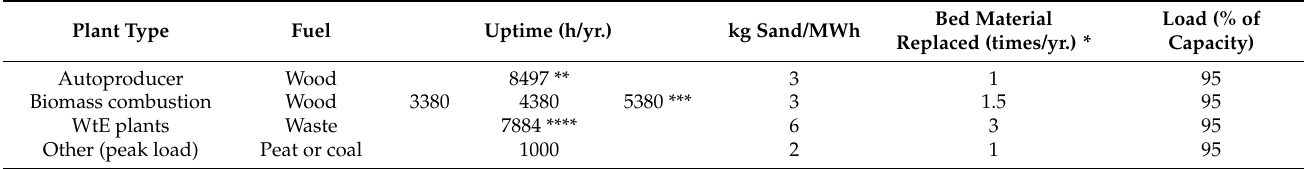
Table 2. Assumptions used for calculating the annual consumption of bed material in fluidized bed boilers in Sweden. Plant Type Uptime (h/yr.)